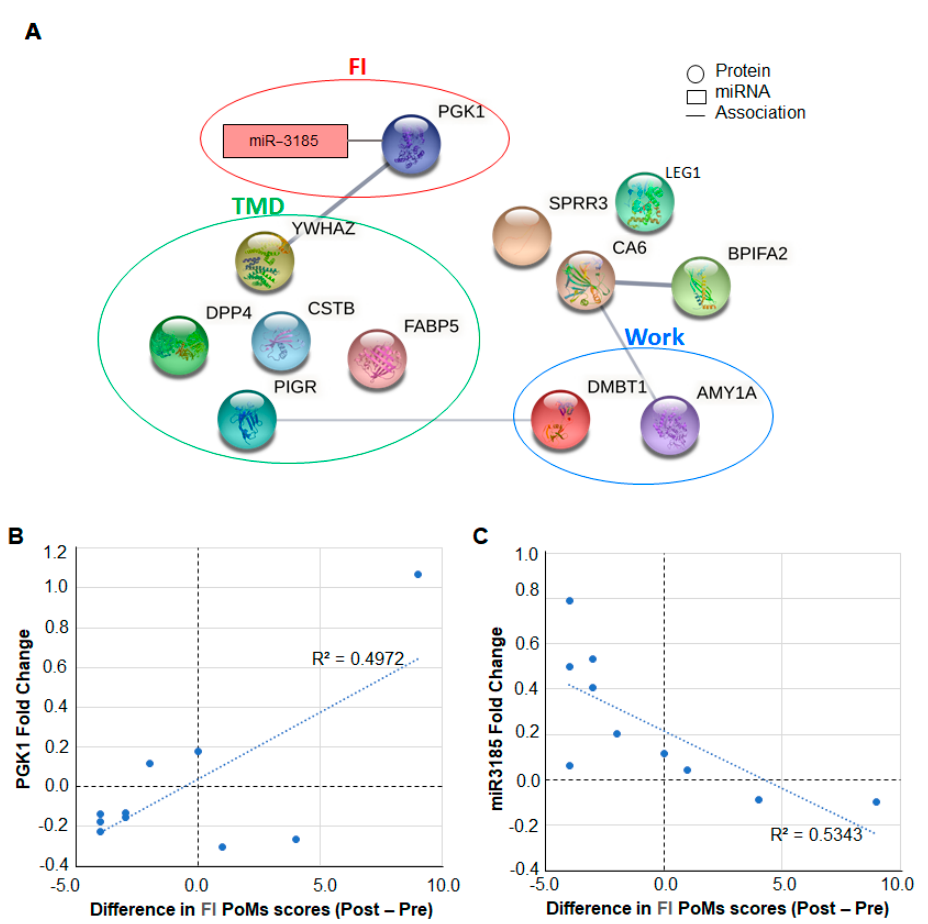
Figure 4. Proteins and miRNA identified in the Validation group are associated with Total Mood Disturbance (TMD), Fatigue–Inertia (FI), and Work, and ( A ) 12 of the 14 proteins identified as significantly altered in the Discovery group were also identified in the Validation group. The abundance of one protein (PGK1) corelates with FI (red circle), and those of the five proteins (DPP4, PIGR, CSTB, FABP5, and YWHAZ) are associated with TMD (green circle). Of the remaining six proteins, two (AMY1A and DMBT1) were altered significantly ( p < 0.05) after a 12 h work shift (blue circle), while the remaining four (BPIFA2, CA6, SPRR3, and LEG1) were not altered. ( B ) PGK1 fold change ( y -axis) shows a weak positive correlation (R 2 = 0.50, r (10) = 0.70, p = 0.0242) and ( C ) miR3185 fold change ( y -axis) shows a weak negative correlation (R 2 = 0.53, r (10) = − 0.73, p = 0.0165) with FI difference in Validation group participants after a work shift.